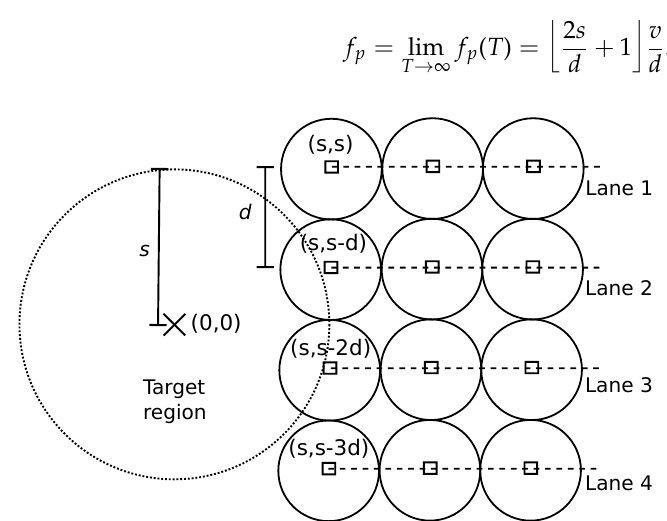
Figure 4. Example of the parallel lanes strategy.